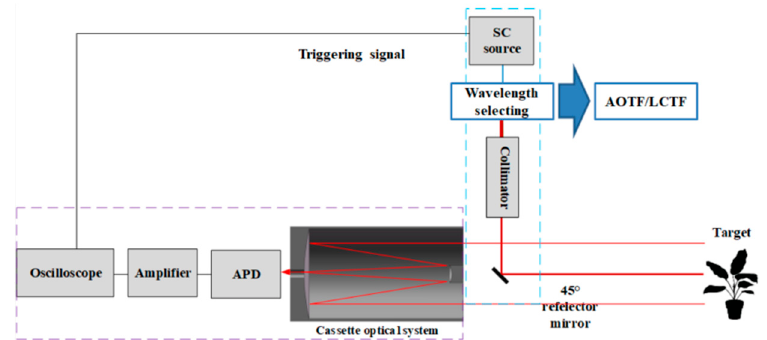
Figure 1. Schematic diagram of a tunable Hyperspectral LiDAR system based on AOTF.